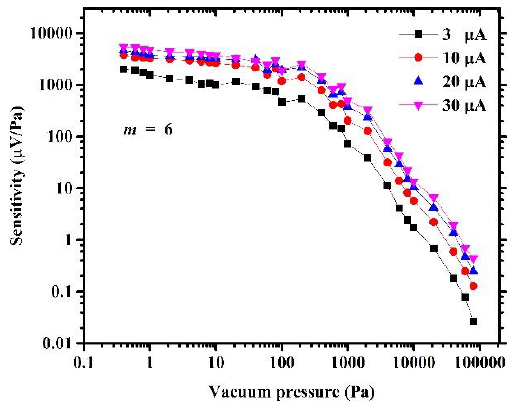
Figure 12. Sensitivity of the six-series-diode-based micro-Pirani vacuum sensor is proportional to the forward bias current and inversely proportional to vacuum pressure.